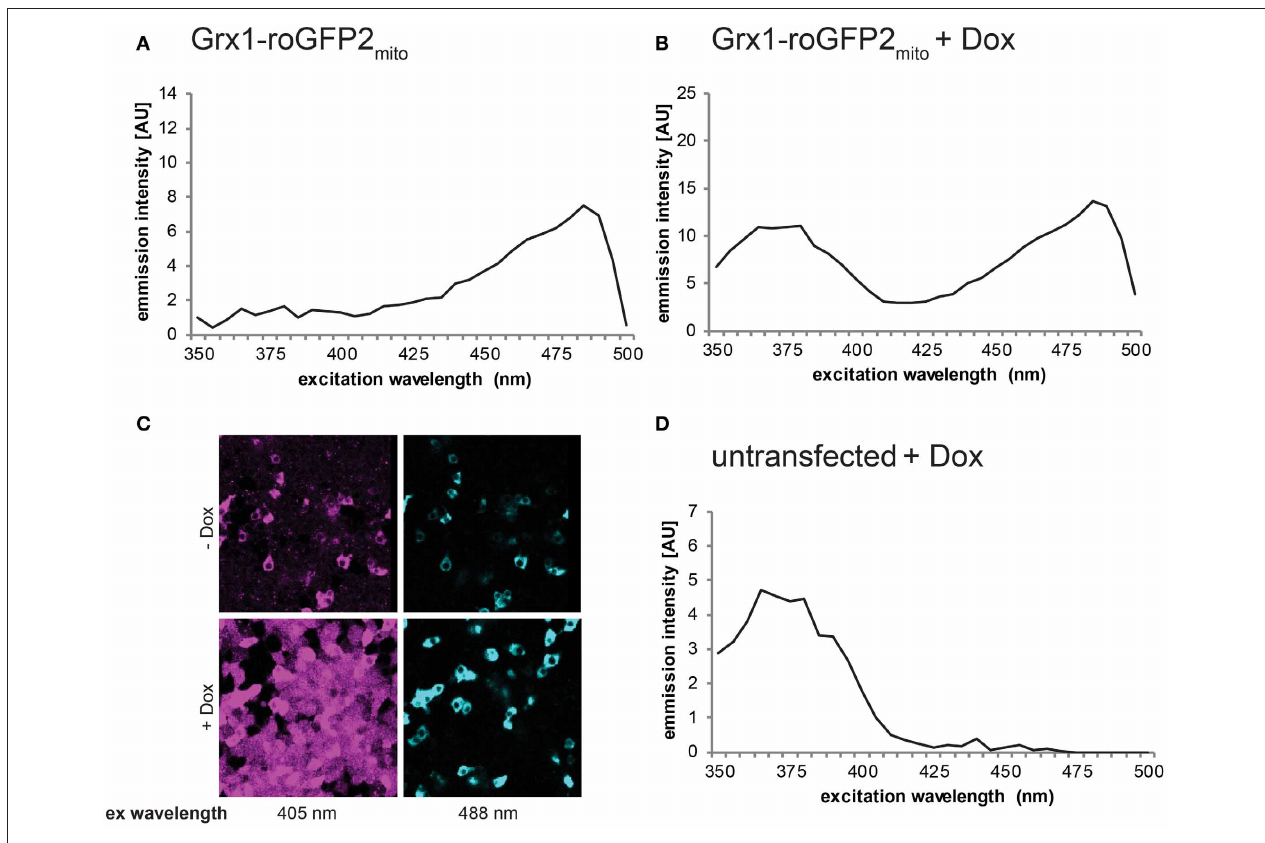
FIGURE 5 | Fluorescence of doxycycline prohibits roGFP-based redox analysis. Cells were transiently transfected with mitochondrial Grx1-roGFP2 (Grx1-roGFP2 mito ) (Gutscher et al., 2008) and induced with doxycycline (Dox) for 24h. While non-induced cells displayed a normal roGFP spectrum (A) , Dox treated cells showed an altered peak at